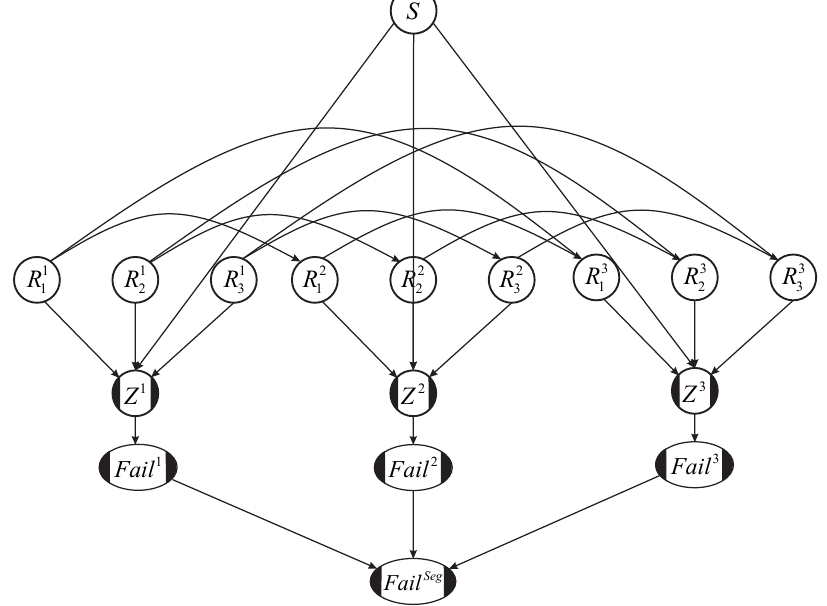
Figure 7. BN for a levee segment, in this example represented by three cross sections, each with autocorrelated resistance variables R 1 , R 2 , and R 3 , and one common load variable S